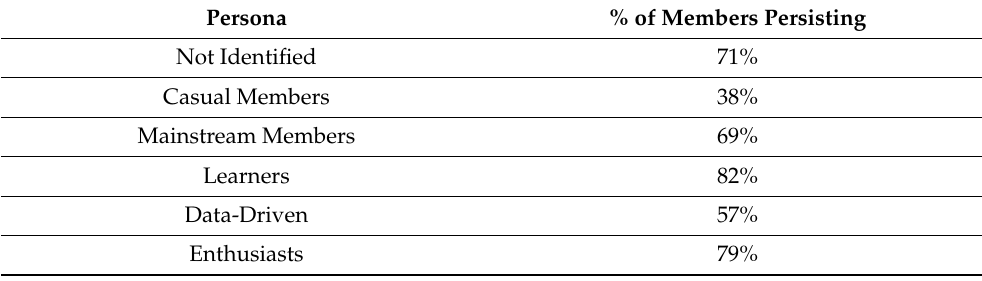
Table A1. The percent of members persisting for each persona when using the alternative hierarchical clustering